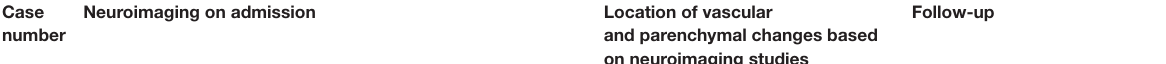
Vessel: RSigS and right frontal and parietal cortical veins. Brain: No parenchyma lesion.